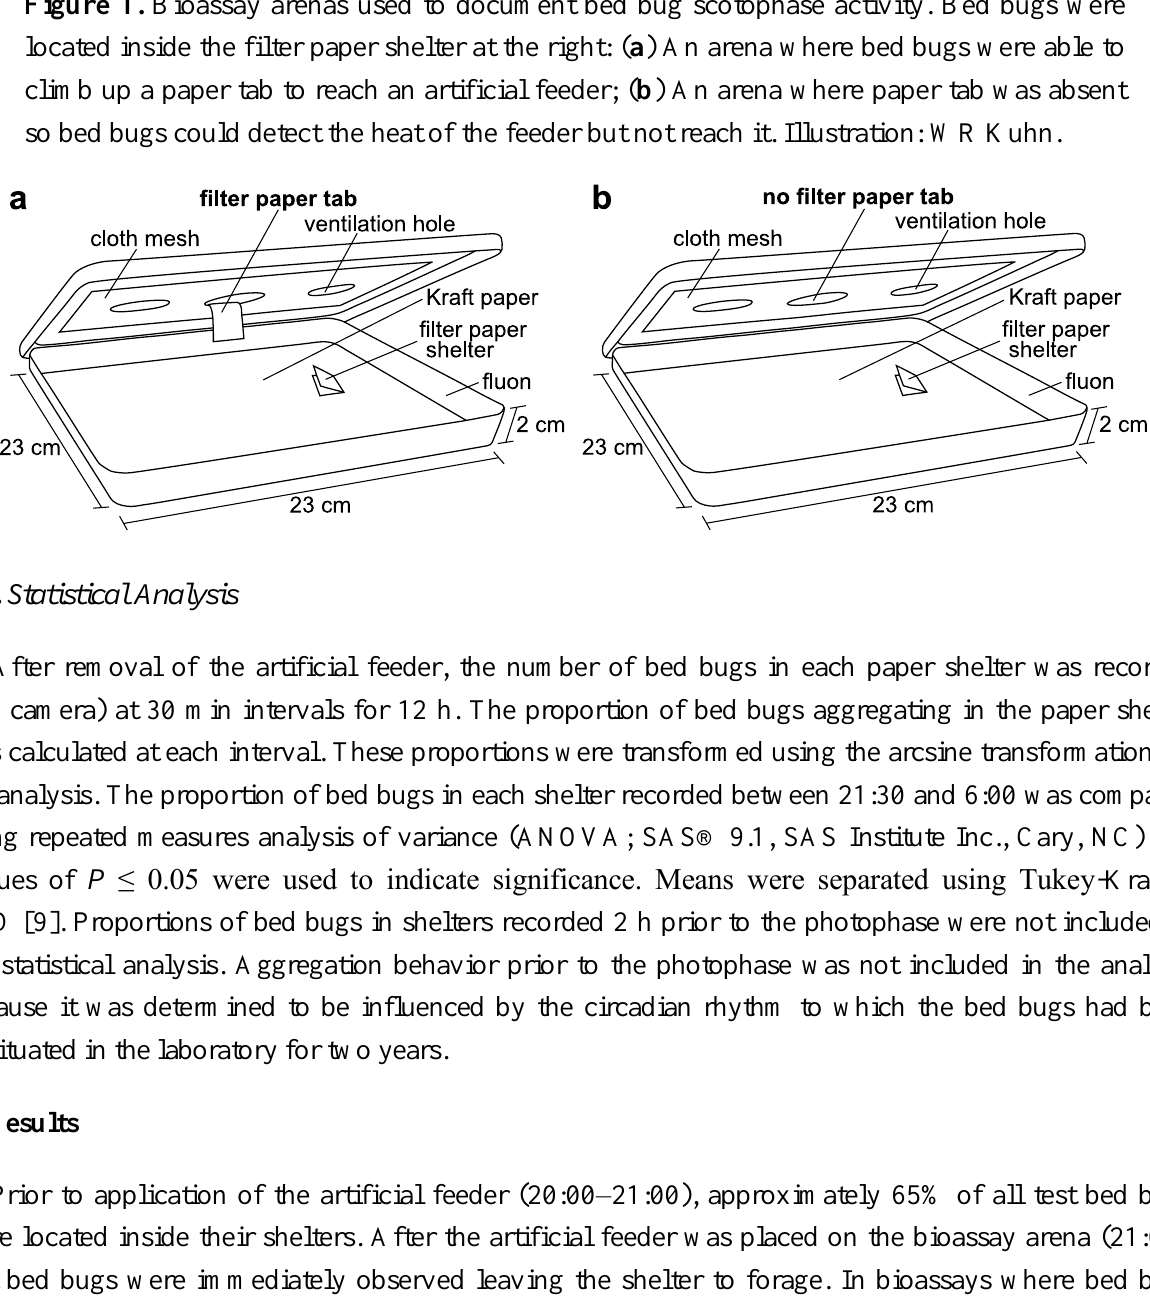
Figure 1. Bioassay arenas used to document bed bug scotophase activity. Bed bugs